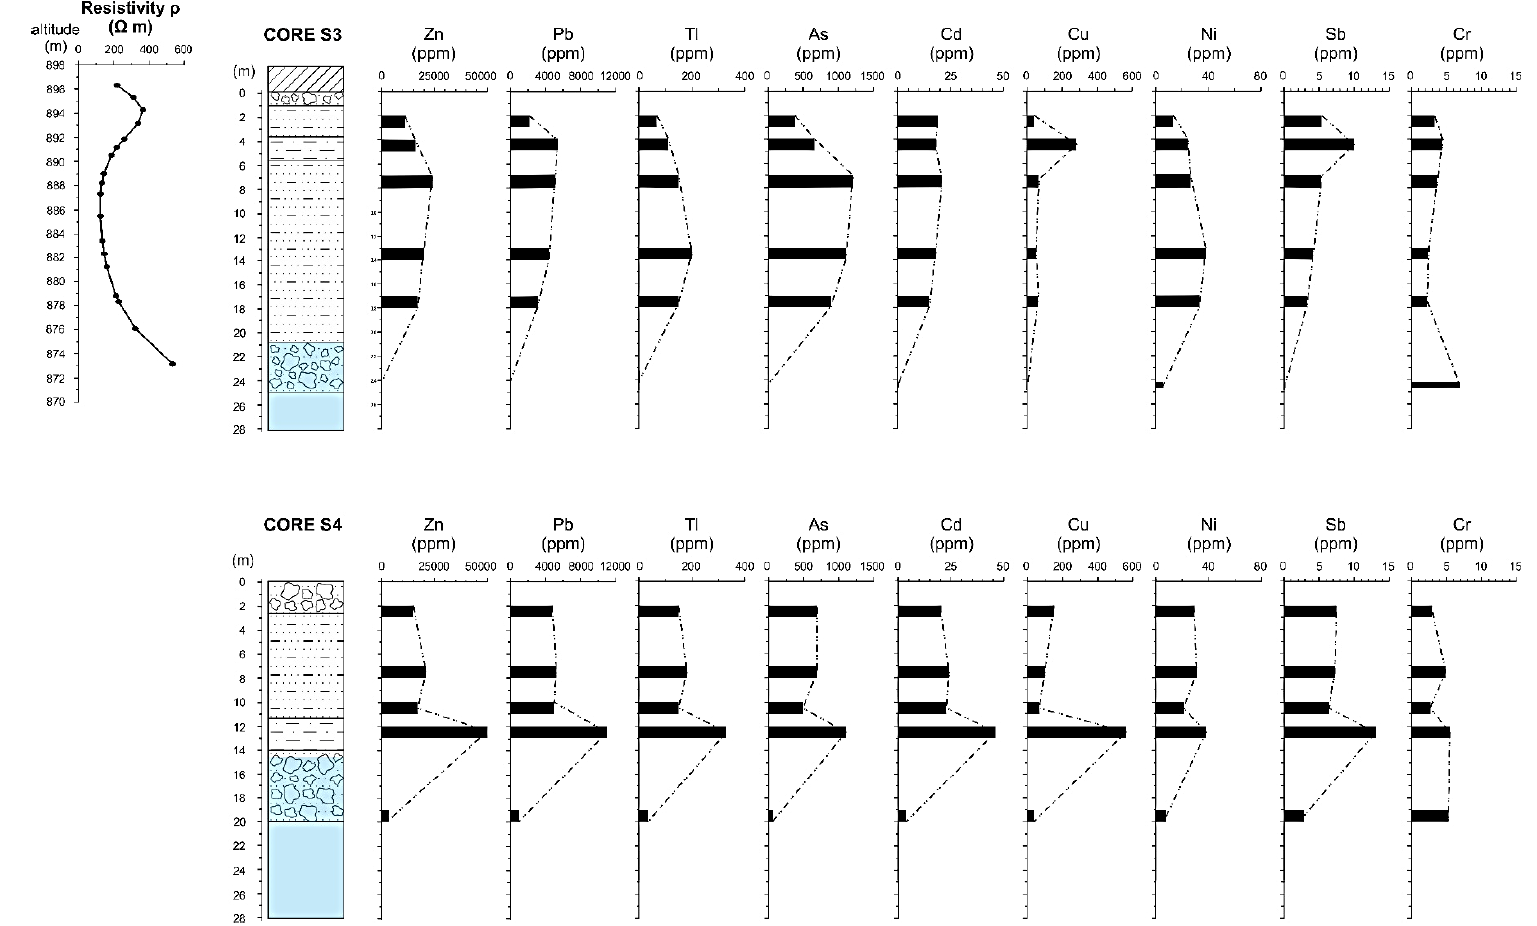
Figure 5. Stratigraphy and vertical profiles of trace element concentrations in the S1, S2, S3, S4 boreholes drilled on the Raibl tailings impoundment. Water table levels (in light blue) refer to values for June – July 2007.